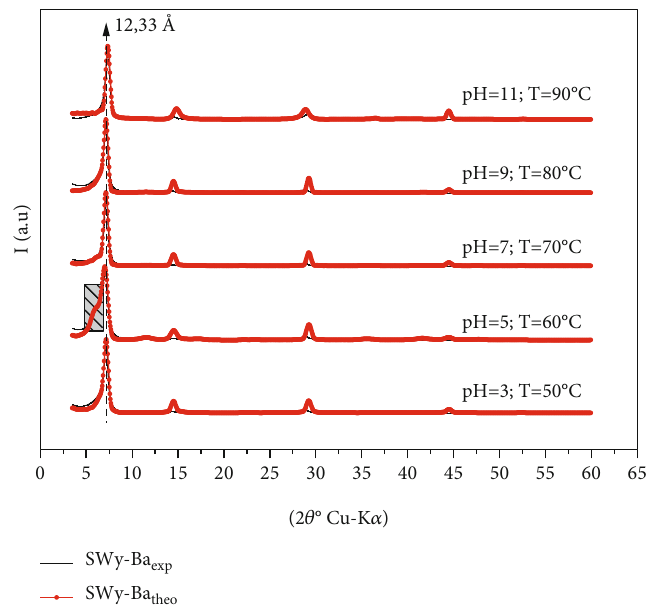
Figure 8: Best agreement between theoretical and experimental XRD pro fi les obtained in the case of